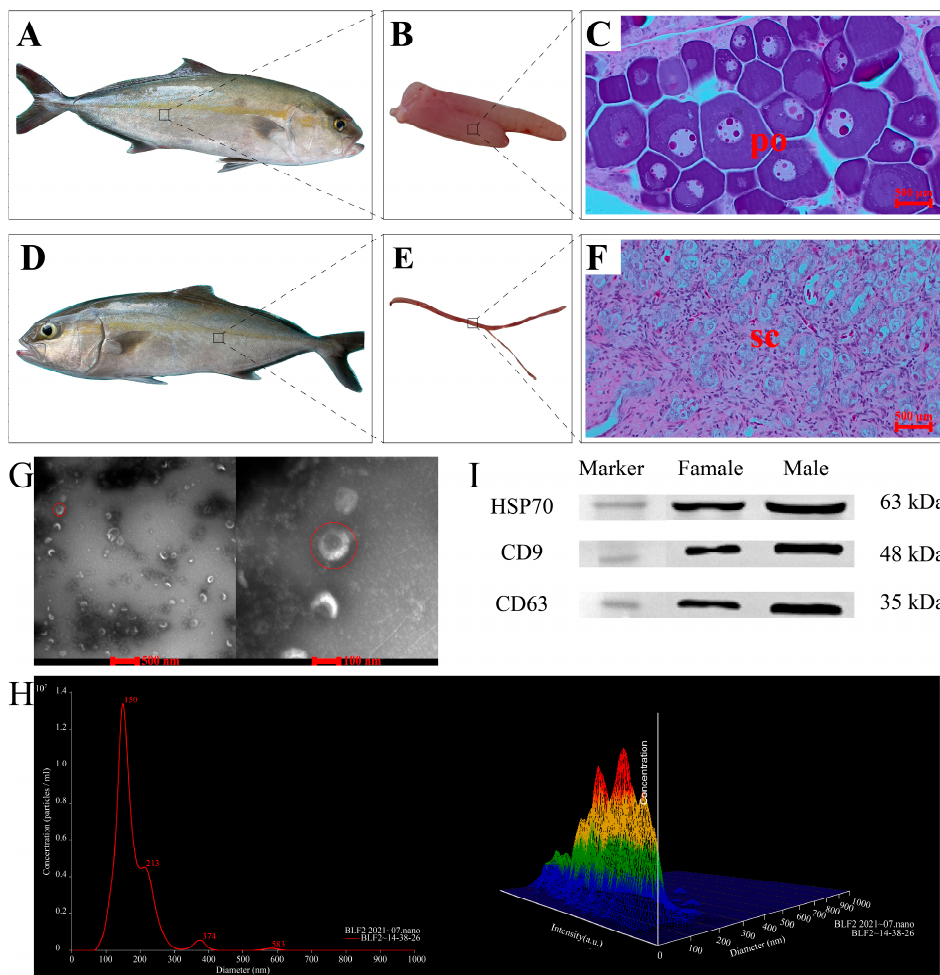
Figure 1. Morphology of greater amberjack and its gonads, histological sections of the gonads, and isolation and identification of exosomes from greater amberjack serum. Morphological and histological results for ( A – C ) female greater amberjack; ( D – F ) male greater amberjack. ( G ) Electron microscope images of exosomes. The red circle on the left shows the electron microscope image of a exosome at a resolution of 100 nm, while the red circle on the right shows that of the exosome at a resolution of 500 nm. ( H ) Particle size distributions and concentration of exosomes in a female greater amberjack determined by NTA 2.3. Left : Line chart. The x -axis represents the diameter of the particles, and the y -axis represents the concentration of the particles. The red number represents the value corresponding to each peak. Right : Three-dimensional graph. The x -axis represents the diameter of the particles, and the y -axis represents the intensity of the particles, and the z -axis represents the concentration of the particles. The color represents the value of the diameter, intensity and concentration of a particle. A redder color indicates a larger value, followed by yellow and green, while a bluer color indicates a smaller value. ( I ) Western blotting for the detection of heat shock protein 70, tetraspanin CD9, and tetraspanin CD63. po, primary oocytes. sc, spermatocytes.